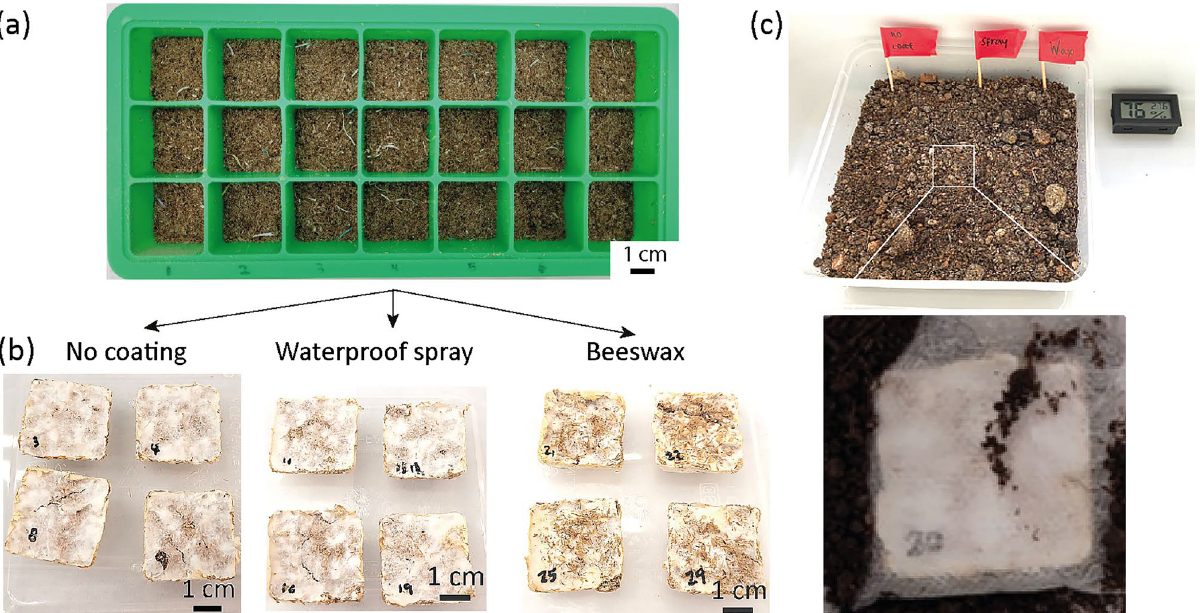
Figure 2. Experimental set-up. ( a ) Picture of the substrate placed in the ice tray molds at day 0 for the growth of the MBCs. ( b ) Pictures of the MBCs after 28 days fungal growth and drying, with no coating, waterproof spray coating and beeswax coating. ( c ) Experimental set-up for the composting showing the soil with outdoor tropical conditions and a picture of a MBC sample placed inside a pouch before its burial in the